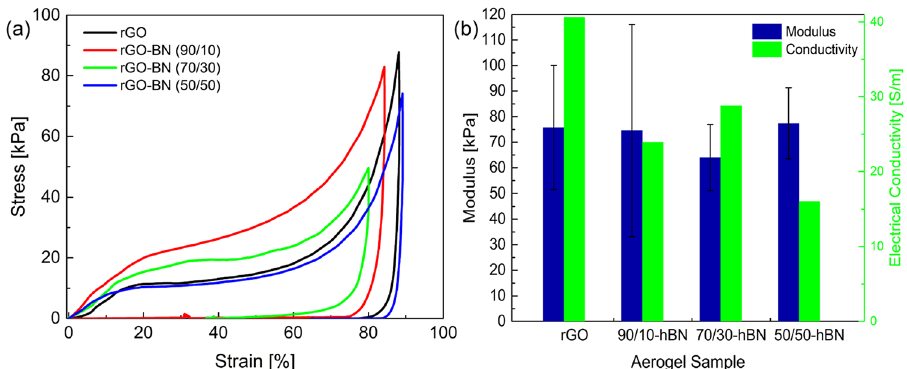
Figure 5. ( a ) Representative stress–strain curves under compression for all the examined aerogels, namely rGO, 90/10, 70/30 and 50/50. ( b ) Compressive modulus (left columns) and electrical conductivity (right columns) for all tested aerogel samples.